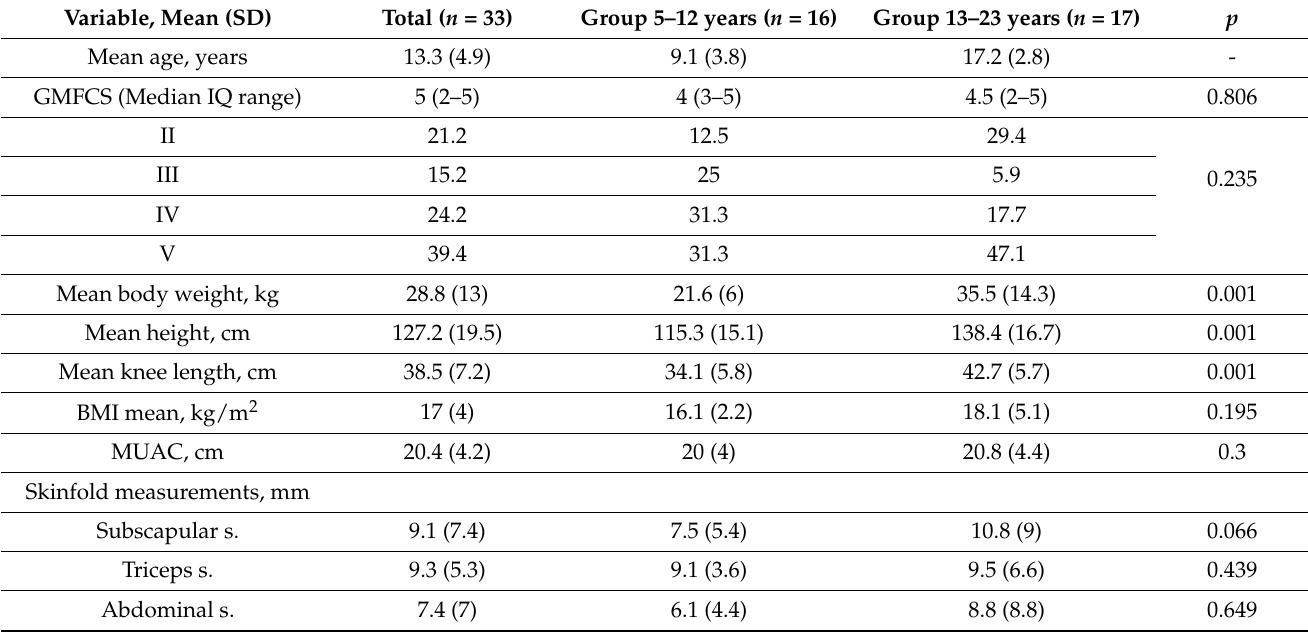
Table 1. Anthropometric characteristics of students according to age